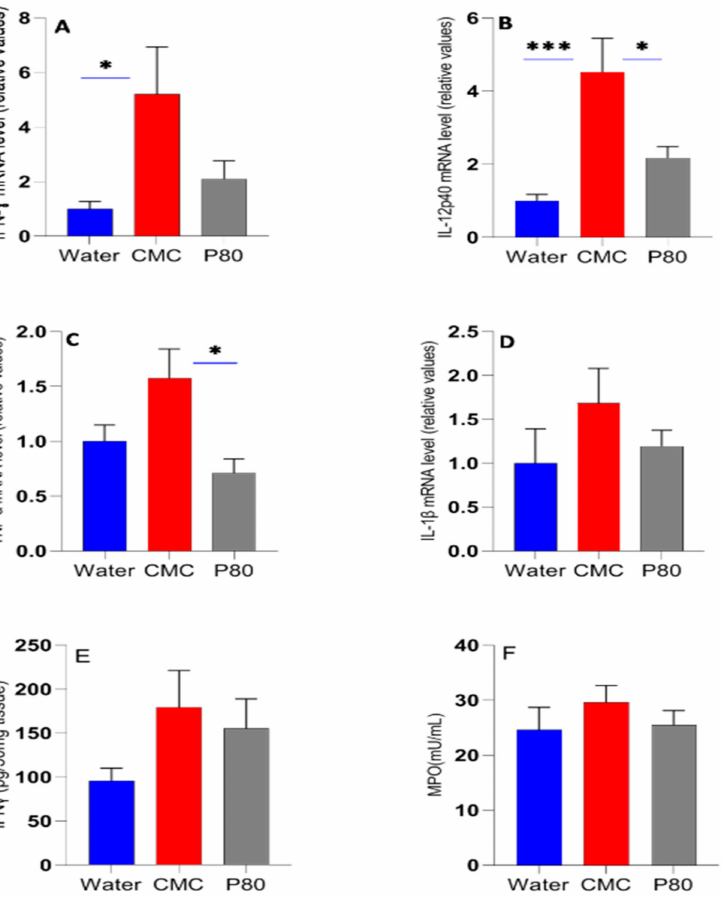
Figure 2. The distal colonic expression of IFN- γ , IL-12p40, TNF- α , and IL-1 β mRNA ( A – D ), colonic IFN- γ concentration ( E ), and colonic MPO activity levels ( F ) in mice treated with CMC (1% w / v , red), P80 (1% v / v , gray), and water (control, blue) performed by qPCR. * p < 0.05; *** p < 0.001 by one-way ANOVA followed by Tukey multiple comparisons